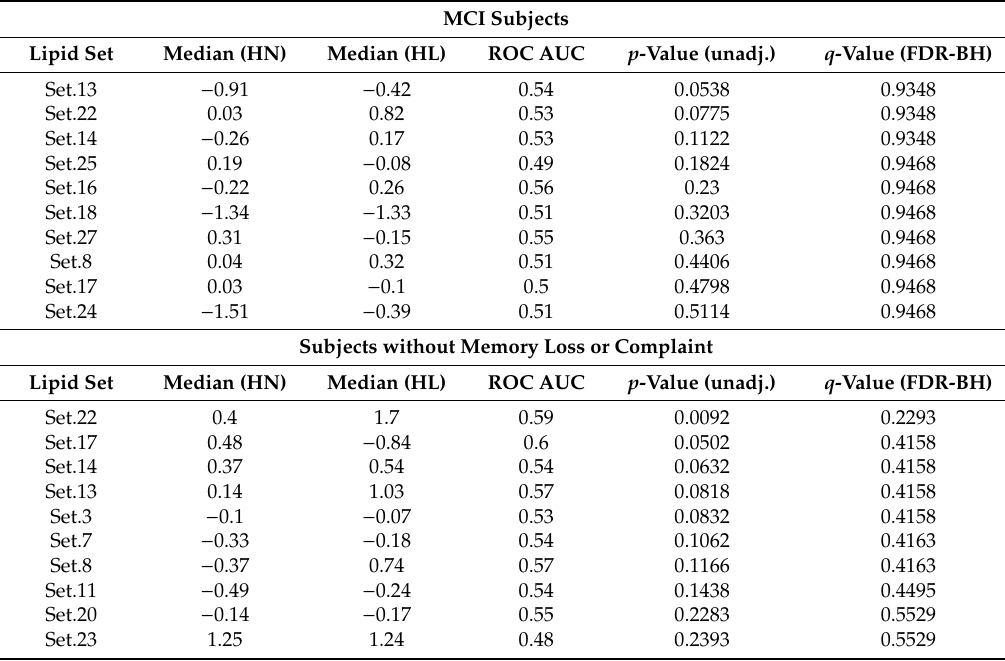
Table 6. Table of lipid sets derived from Barupal et al. (2019) and their performance in distinguishing HL from NHL in mild cognitive impairment (MCI) and NL subjects. ROC AUC = receiver operating characteristic area under the curve. Top ten sets shown for each group of